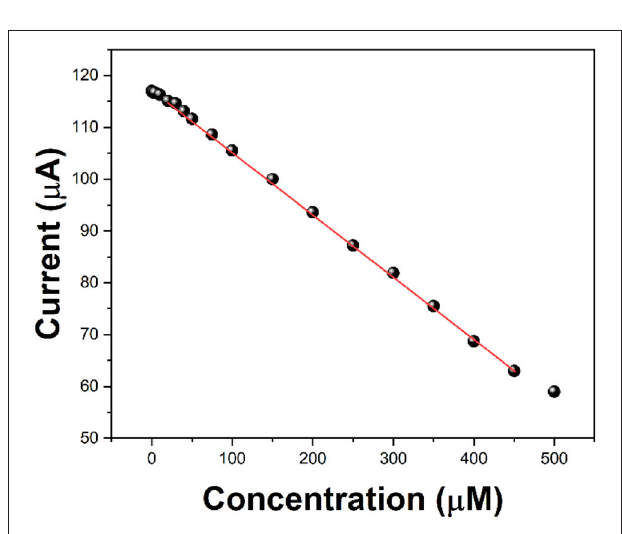
FIGURE 5 | Current value of C/GO/Zn after the injection of 0.1ml of H 2 O 2 (10%) and different concentrations of ascorbic acid.